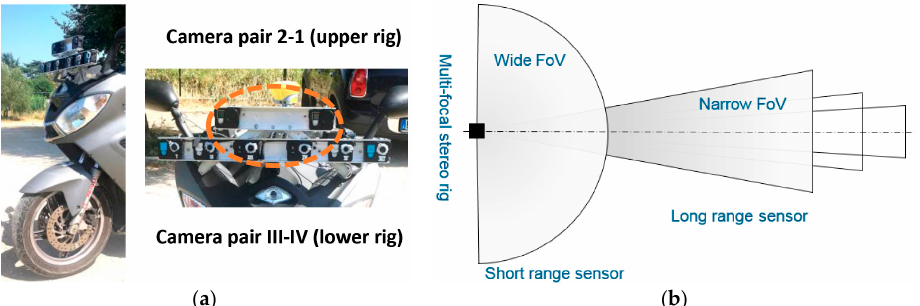
Figure 2. Overview of the imaging system. ( a ) Multi-focal stereo rigs installed in the frontal part of the vehicle and fixed to the scooter frame; ( b ) Top view of the 3D space to measure in front of the scooter (the outer stereo cameras are used for development purposes and future extension of the long range of measurement).